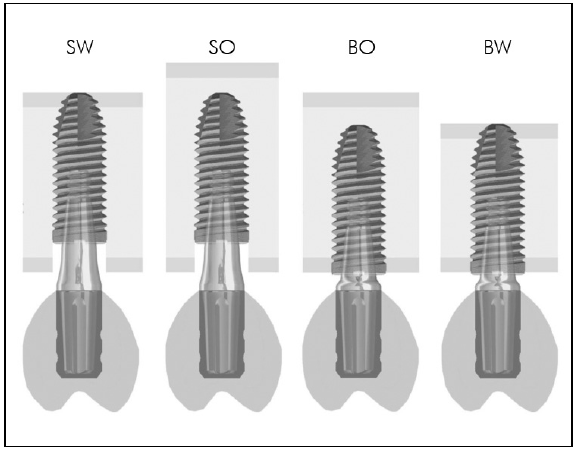
Figure 1. Using a 1-mm-thick cortical layer and different trabecular bone heights, four models are created using one 4.0 × 11-mm implant with platform switching and internal Morse taper connection. Implants were positioned 2 mm sub- crestally with (SW) or without (SO) apical engagement into the cortical bone or positioned at the bone level with anchorage only in the crestal cortical bone (BO) or with bicortical fixation